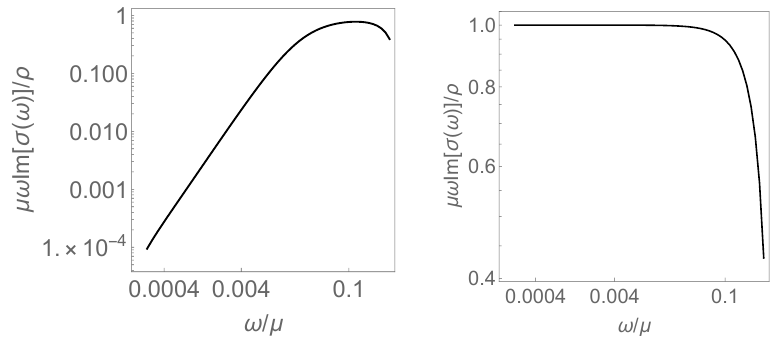
√ 10 showing complete